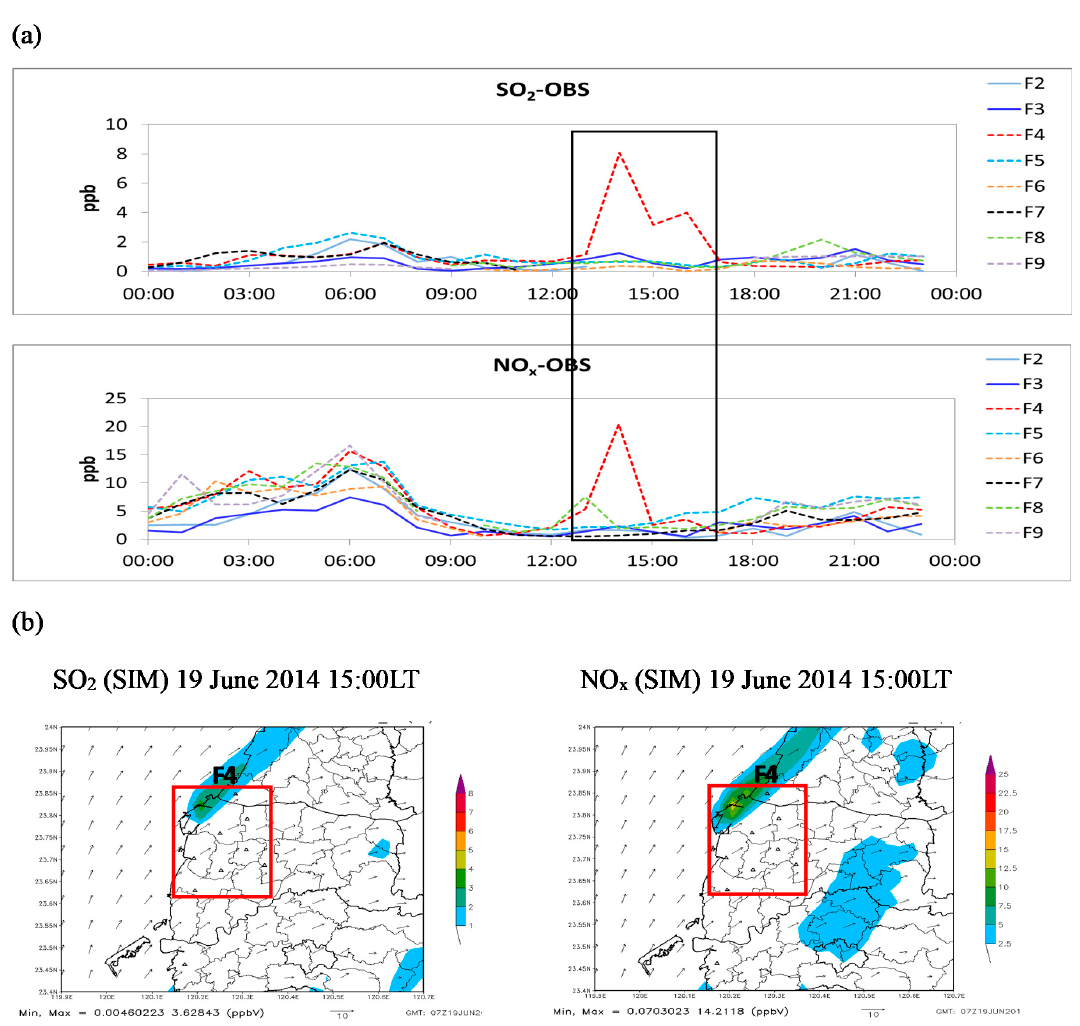
Figure 8. ( a ) Diurnal variations of SO 2 and NO x observations at eight AQSs on 19 June 2014. ( b ) Progression of surface wind field (m / s), SO 2 , and NO x (ppbv) from simulations under a typical SWM condition on 19 June 2014. The red box represents the Petro–region and the triangles represent AQSs.